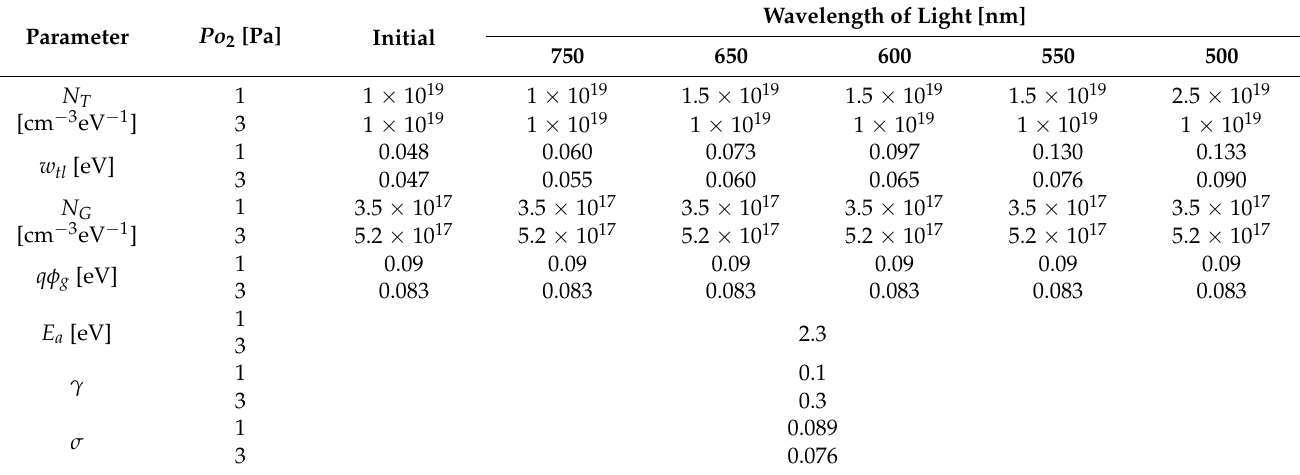
Figure 8. Measured evolution of transfer curves as a function of various conditions of monochromatic light illumination for a-IGZO TFTs fabricated with different Po 2 values compared with model results: ( a ) 1 Pa and ( b ) 3 Pa. Table 3. Parameters of the DOSs under illumination.